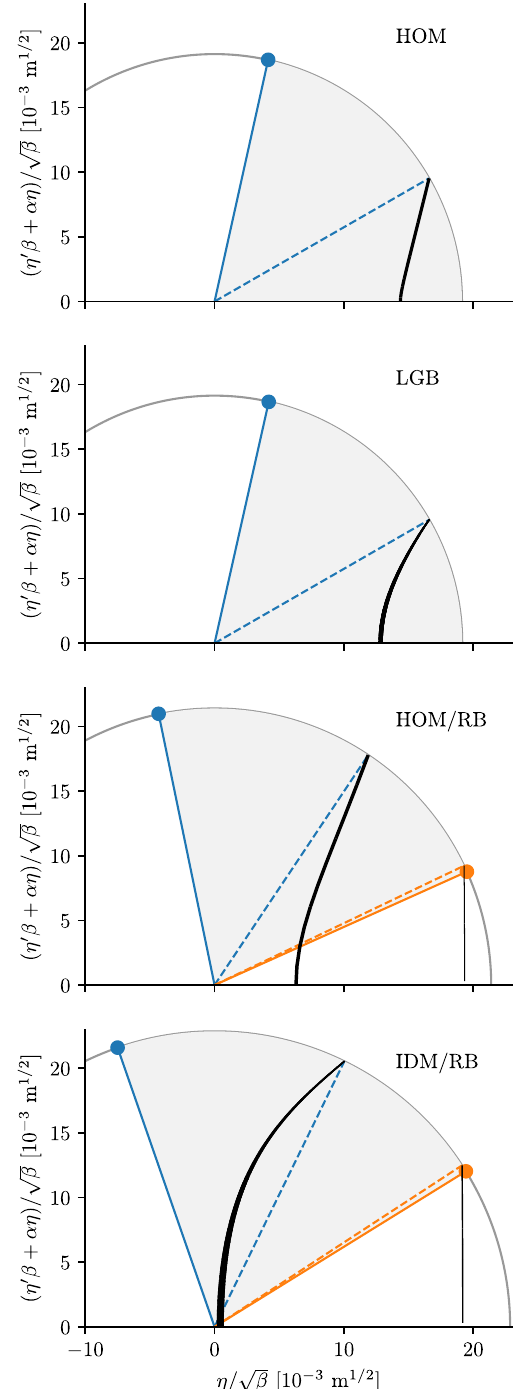
, nat FIG. 19. Dispersion in normalized phasespace (black lines) for four example cells; the line thickness corresponds to local field ⃗ P ⃗ P strength. Markers indicate 0 (blue) and 1 (orange). Dashed lines mark the betatron phase at the exit of the main bend (blue) and the entrance of the reverse bend (orange). Thus the angle between solid and dashed line of the same color is the phase advance inside the respective half-bend. The angle included in the ⃗ P ⃗ P shaded arc (limited by 0 , 1 ) is the half-cell phase advance ϕ (77.4° for shown